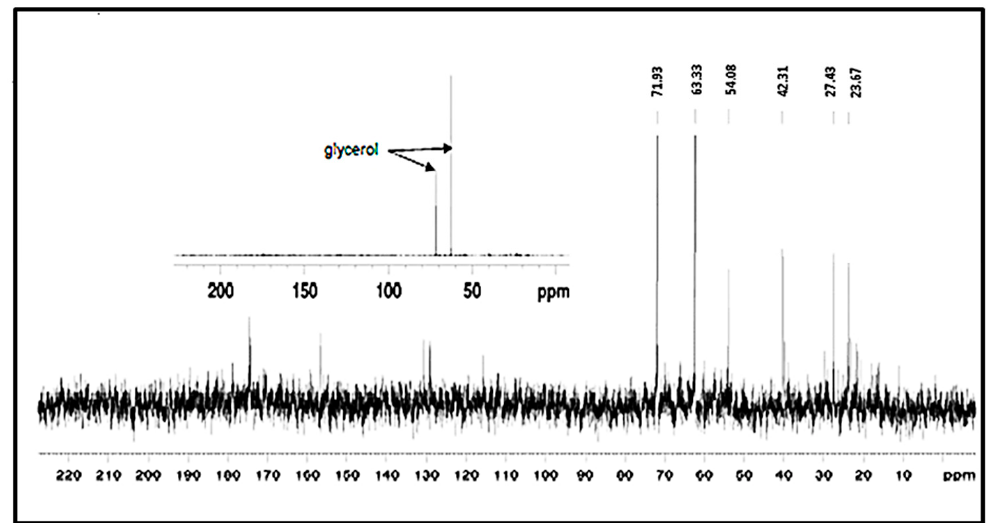
Figure 6. 13 C NMR spectrum of the EPS of L. monocytogenes . The EPS of L. monocytogenes (30 mg) was dissolved in 4% deuterated water. Spectra were acquired with 13 C NMR and peaks due to the carbons in glycerol were visible.